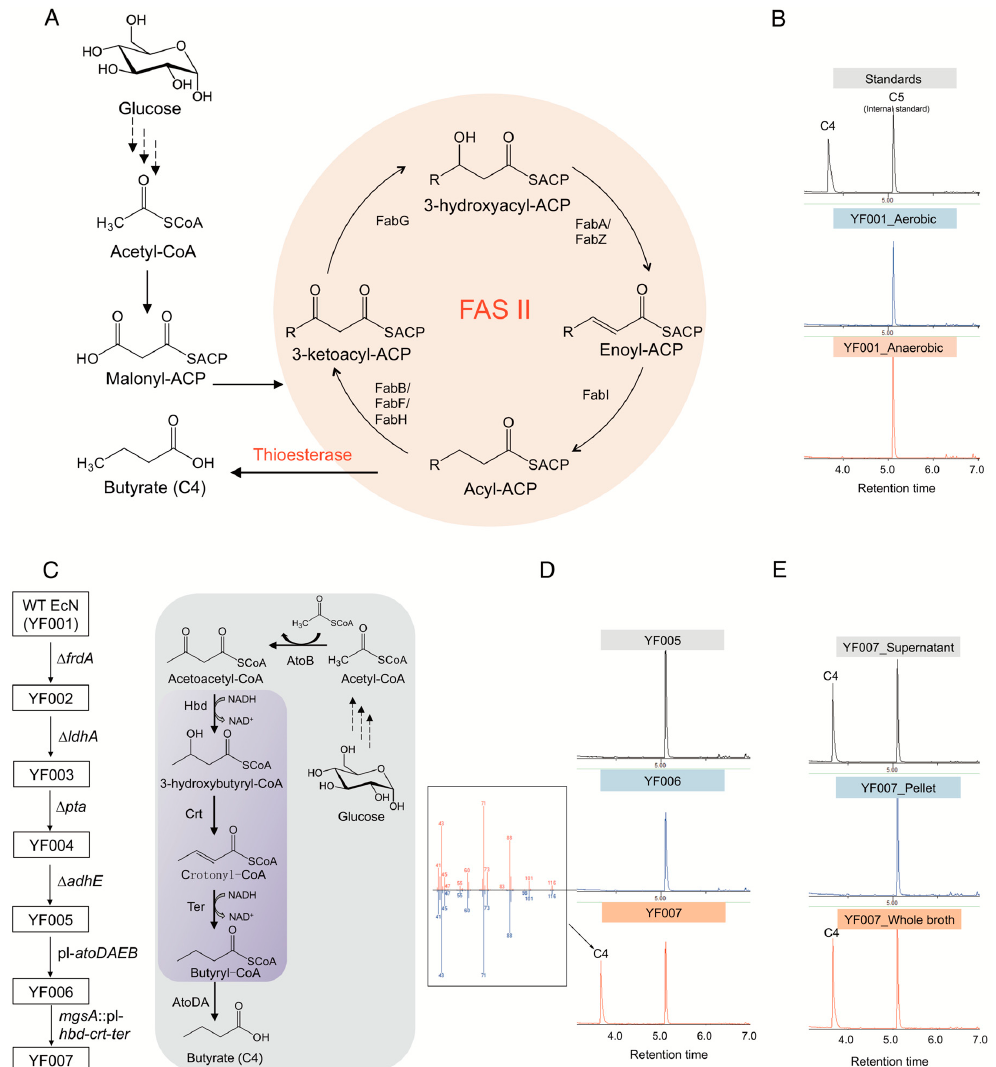
Figure 1. Synthesis of butyrate in Escherichia coli Nissle 1917 (EcN). ( A ) Butyrate production